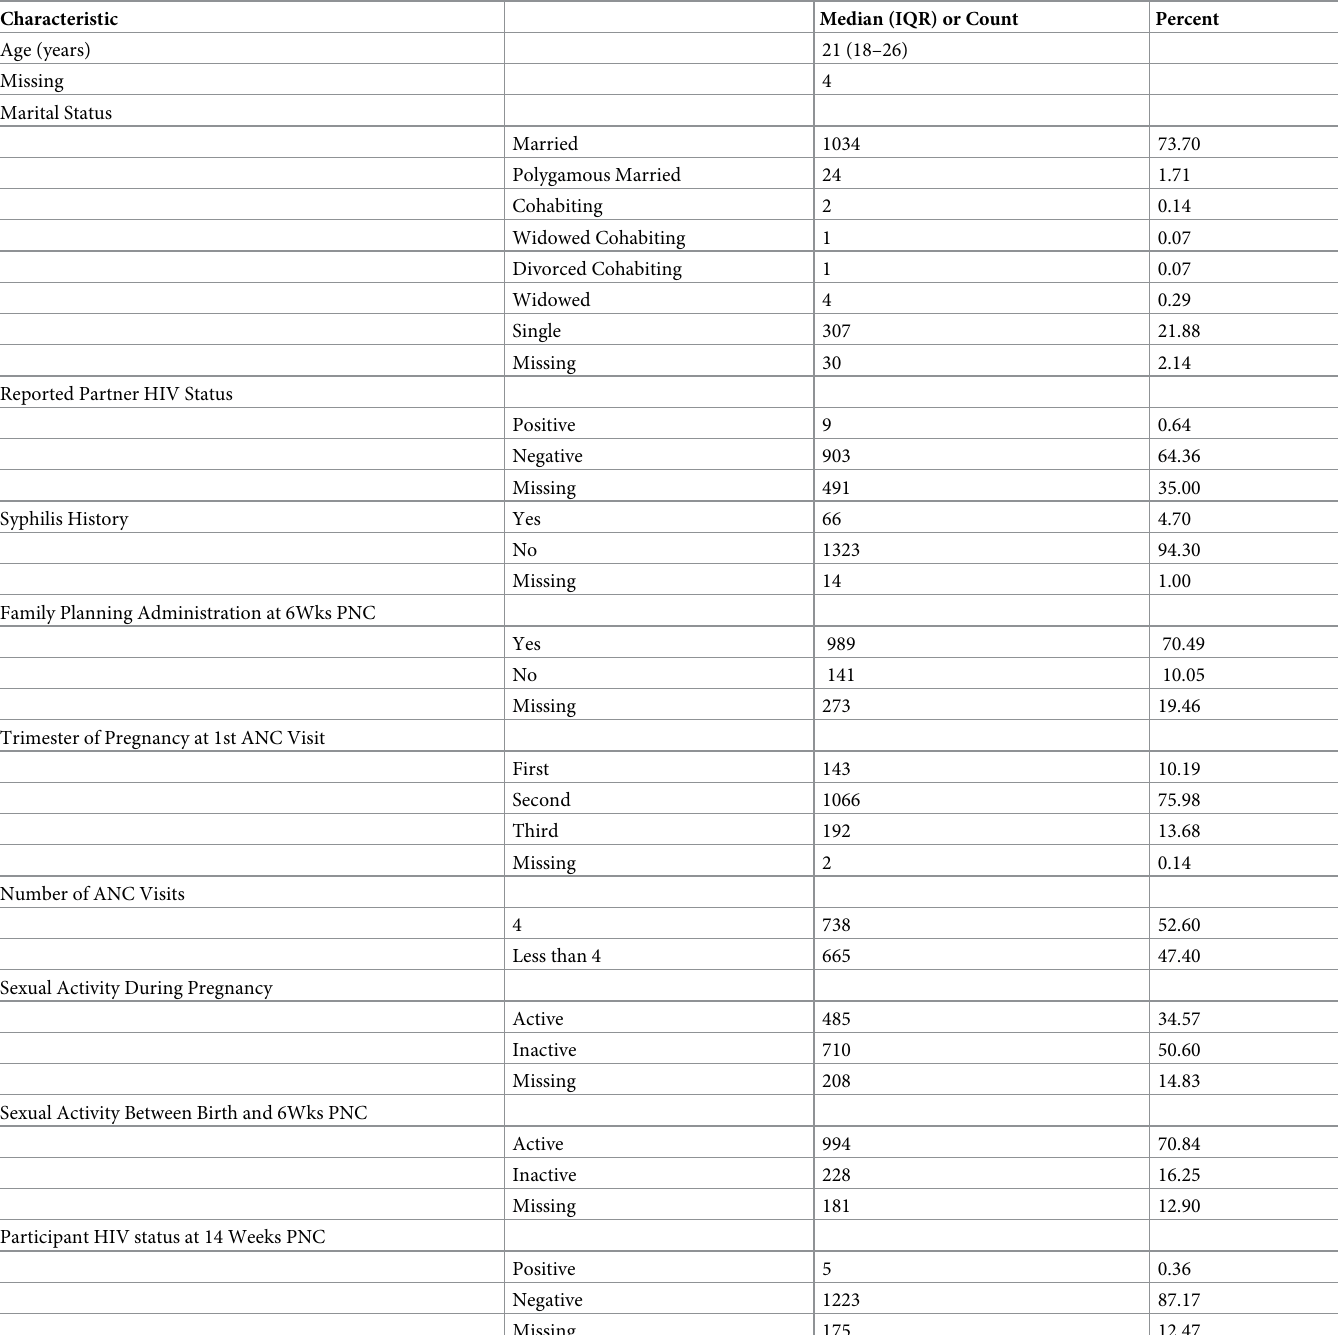
Table 1. Demographic and clinical characteristics of participants (N =